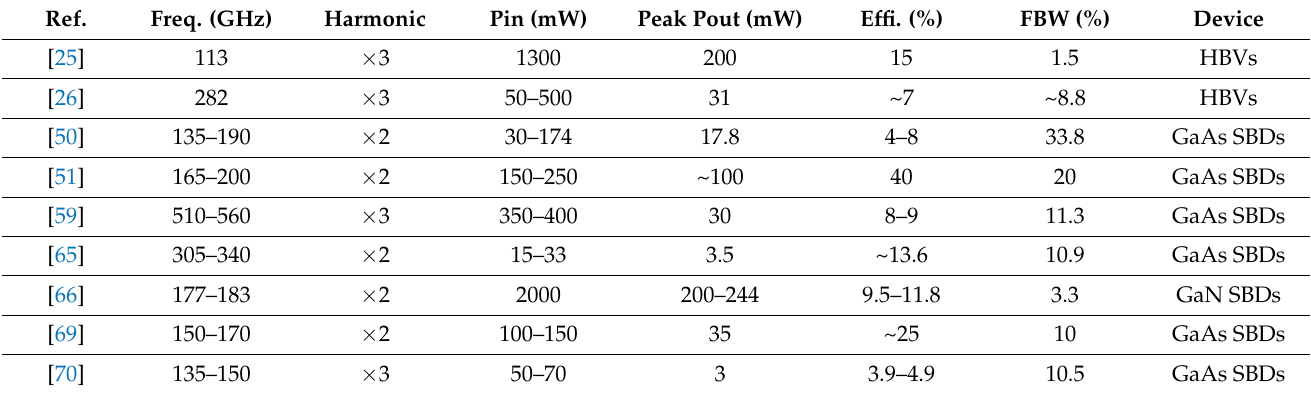
Table 1. Performance summary and comparison between state-of-the-art frequency multipliers.